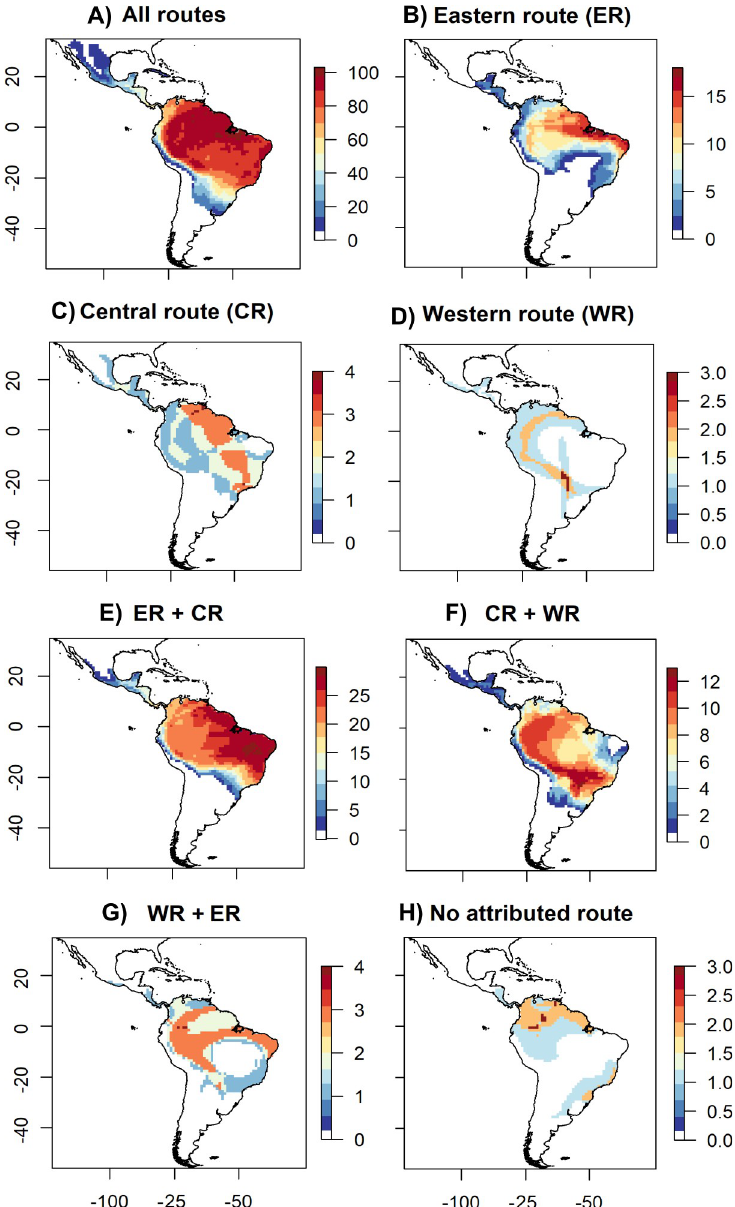
Fig 2. Overlap in mammal species distributions and tropical moist forest connective routes. The colour scale represents the number of species per pixel in the map. A) Overlap in species distributions with tropical moist forest habitat for all mammal species sampled in this study; B) Overlap in species distributions with the Eastern route; C) Overlap in species distributions with the Central route; D) Overlap in species distributions with the Western route; E) Overlap in species distributions with both the Eastern and Central routes; F) Overlap in species distributions with both the Central and Western routes; G) Overlap in species distributions with both the Western and Eastern routes; and H) Overlap in species distributions with no attributed route. Most species were associated with the Eastern route, followed by the Central route and finally the smallest number of species were associated with the Western route.